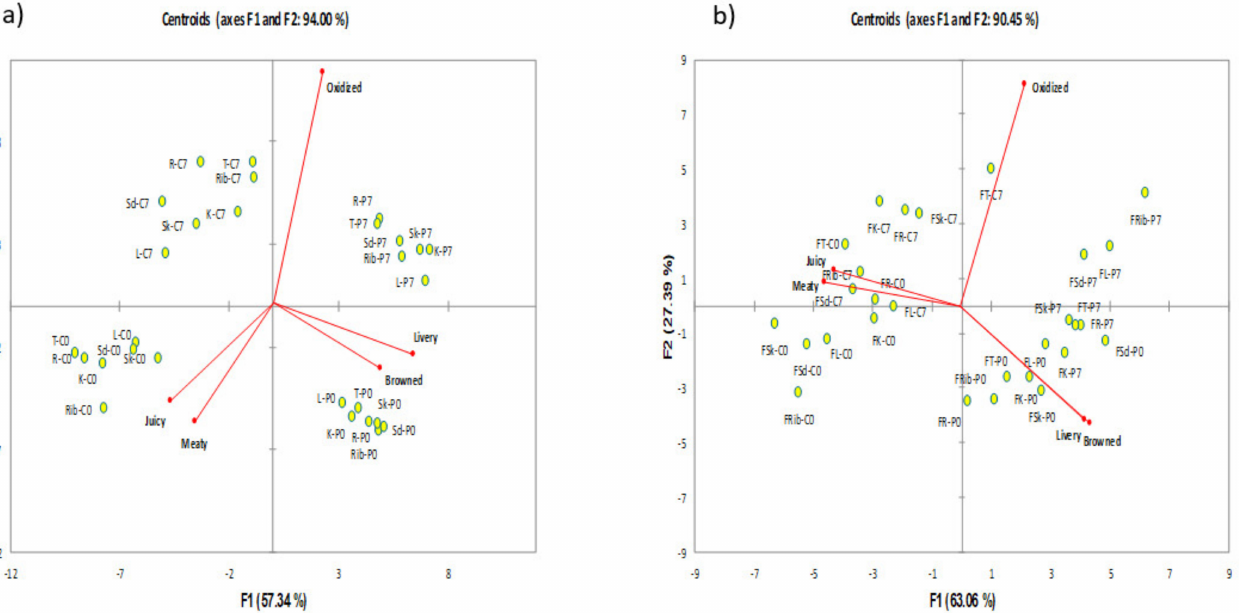
Figure 3. Canonical Variate Analysis Biplot of dominance durations of sensations of PEF and non-PEF treated cooked chilled ( a ) and frozen-thawed ( b ) lamb meat of different cuts. Hotelling–Lawley trace MANOVA test showed significant product differences (( a ): F (135,192) = 29.655; p < 0.001; ( b ): F (135,192) = 12.043; p < 0.001) based on sensory attributes. Sd = Shoulder; Rib = Rib; L = Loin; K = Knuckle; R = Rump; S = Shank; T = Topside; C: control; P: PEF; 0 = 0 days storage; 7 = 7 days storage/post-processing